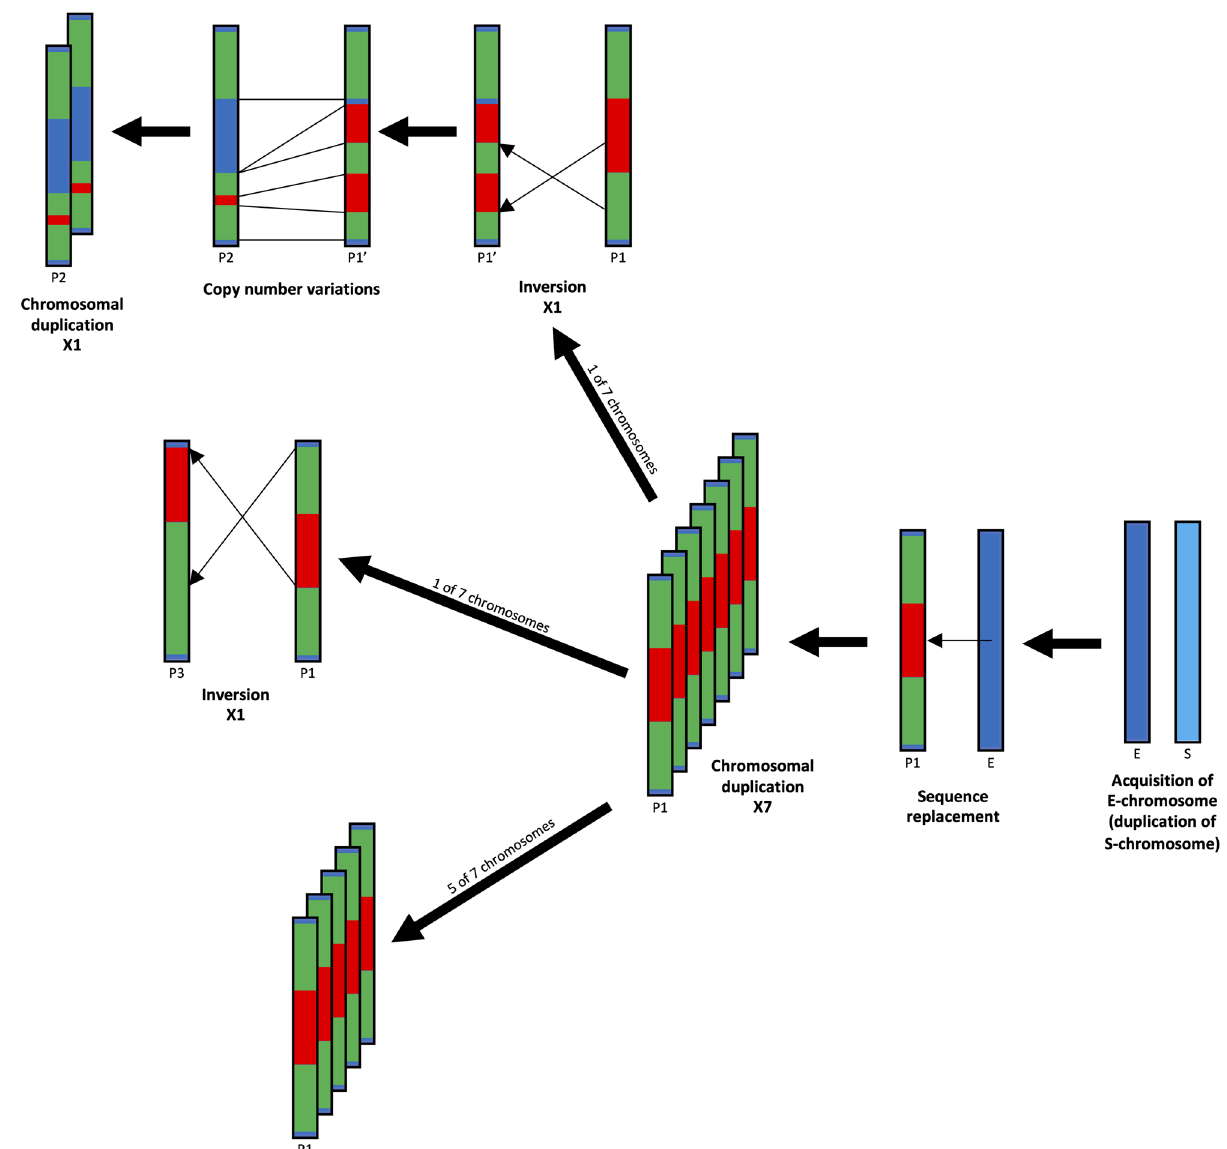
Figure 6. A hypothetical scheme of the evolution of E-chromosomes in E. burgeri . This representation is based on the results of FISH using EEEb1 to EEEb6 presented in this study (Fig. 5). Single P1 (Pattern 1) E-chromosomes containing EEEb1 (green) and other EEEb families (red) were duplicated seven times via meiotic drive after the comprehensive sequence replacement of E-chromosomes (E). P2 (Pattern 2) E-chromosomes were formed by a series of single chromosomal inversion, copy number variations and single chromosomal duplication of one of seven P1 E-chromosome. P3 (Pattern 3) E-chromosome were formed by single chromosomal inversion of one of P1 E-chromosome. Homogenization mechanisms retained the P1–3 E-chromosomes during a long evolutionary period. Before the sequence replacement, E-chromosome duplicated from somatically retained chromosome